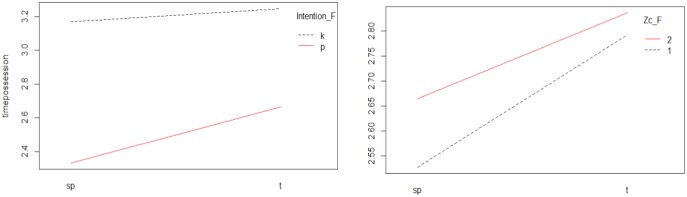
Interaction Type of start-up-Intention and Type of start-up-Zc.